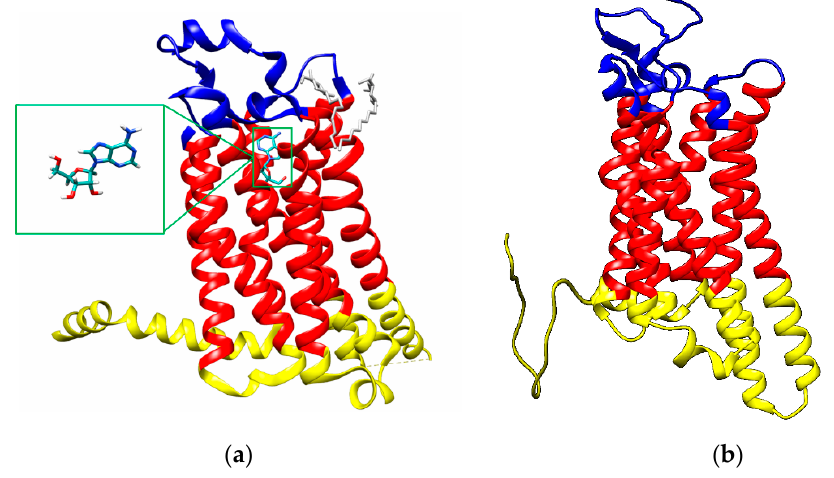
Figure 1. ( a ) X-ray structure of the thermostabilized human A2A receptor with bound adenosine (PDB code: 2YDO [28]; blue: extracellular region, red: transmembrane domain, yellow: cytoplasmic region); insert: adenosine; ( b ) A3 adenosine receptor structures obtained with LOMETS (cyan rectangle: A8.60-E318 region, blue: extracellular region, red: transmembrane domains, yellow: cytoplasmic region).